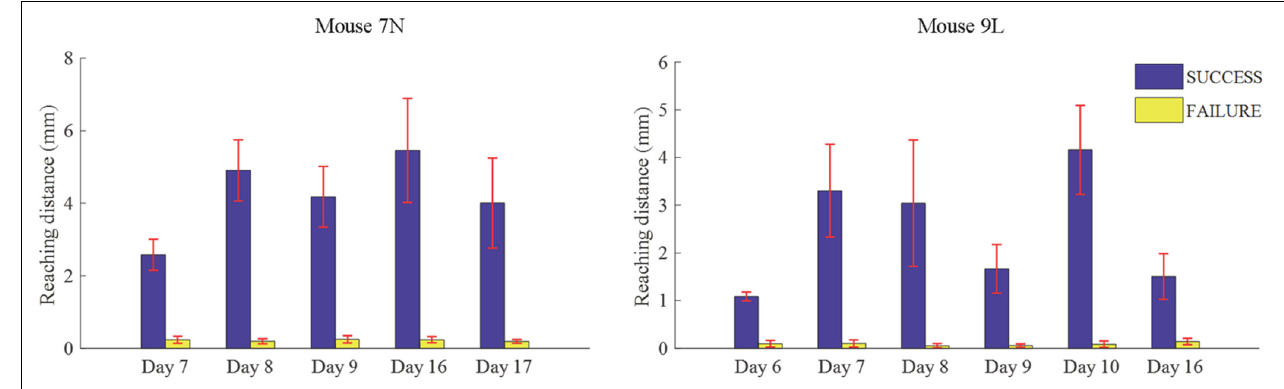
FIGURE 7 | Mean lever reaching distances in each used recording day of mouse 7N (left) and mouse 9L (right). TABLE 3 | Five-fold cross validation results on the prediction of reaching outcome of RFA post-cue and ITI group for mice 7N and 9L with epoch number equals to 300. RFA post-cue RFA ITI Fold No . Accuracy Accuracy Sensitivity Specificity F1-score Accuracy Accuracy Sensitivity Specificity F1-score (Training) (%) (Test) (%) (Training) (%) (Test) (%) Mouse 7N 1st